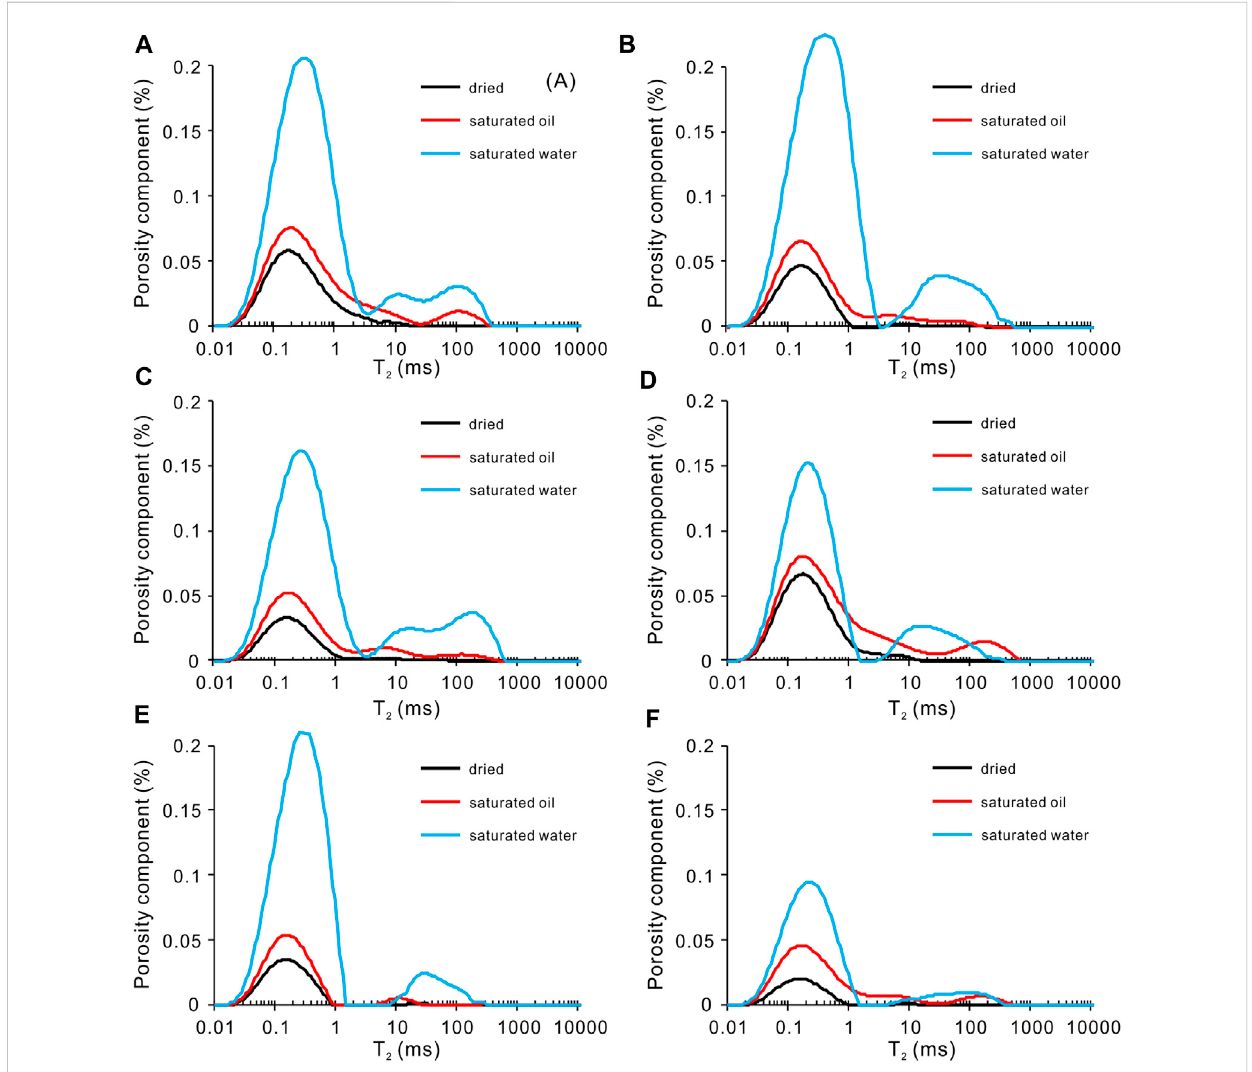
FIGURE 5 NMR T 2 spectra of Jurassic Lianggaoshan Formation lacustrine shale in different lithology combination under different states. (A) Type A shale,Well C, 2455.06m; (B) Type A shale,Well B, 1896.13 m; (C) Type B shale,Well C, 2452.29 m; (D) Type B shale,Well A, 1751.71 m; (E) Type C shale, Well C, 2465.48 m; (F) Type C shale, Well B, 1928.58